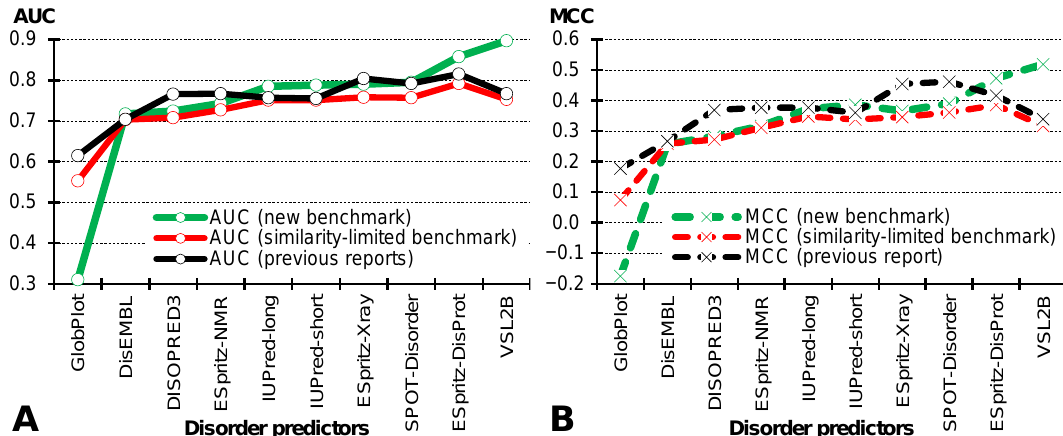
Figure 2. Comparison of the predictive quality measured with AUC (panel A ; solid lines) and MCC (panel B ; dashed lines). We report results on the new benchmark (in green; dataset with <30% sequence similarity to the training proteins + with experimental validation of structured regions + with fully structured proteins), based on recent previous reports (in black; datasets with no limits on sequence similarity to the training proteins + with no experimental validation of structured regions + with only disordered proteins), and based on a similarity-limited benchmark (in red; a version of the new benchmark dataset with <30% sequence similarity to the training proteins + no experimental validation of structured regions + only disordered proteins). The latter dataset is a proxy for the datasets used in prior studies, with the only difference being the reduced similarity to the training proteins. Disorder predictors are sorted by their AUC values on the new benchmark dataset.